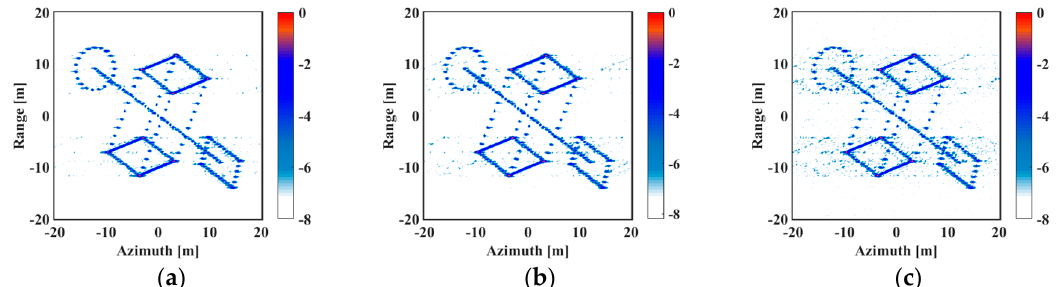
Figure 10. Imaging results obtained by l 1 -norm algorithm under di ff erent SNRs: ( a ) SNR = 10 dBs; ( b ) SNR = 5 dB; ( c ) SNR = 0 dB.